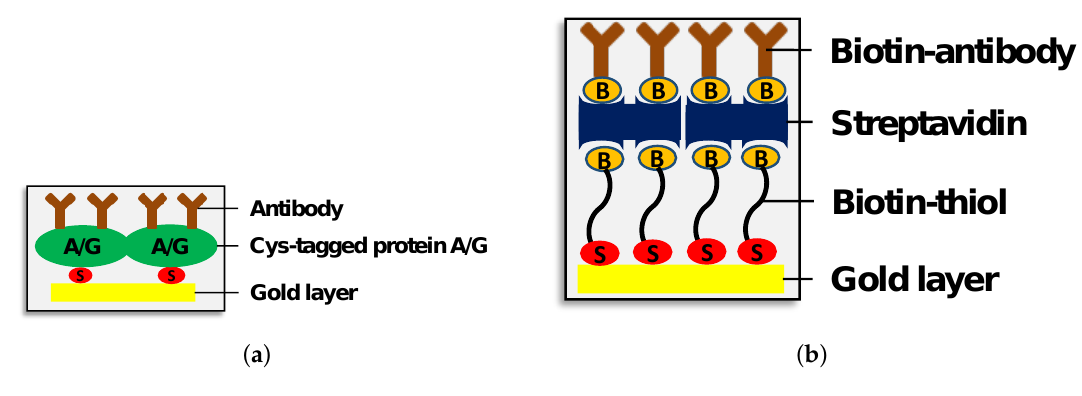
Figure 2. Schemes of the sensor surface functionalization approaches utilized in PAMONO-sensor. Cystein-conjugated protein A/G—antibody (without any conjugated tag) ( a ) and biotin-thiol—streptavidin—biotinylated antibody ( b ) self assembling monolayers can be formed on the gold sensor surface to capture the vesicles of